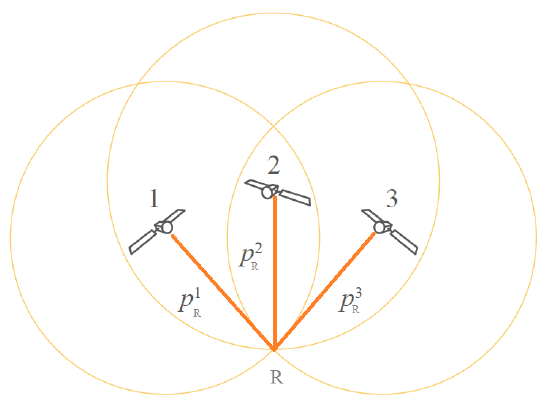
Figure 2. Receiver’s pseudoranges ( p i